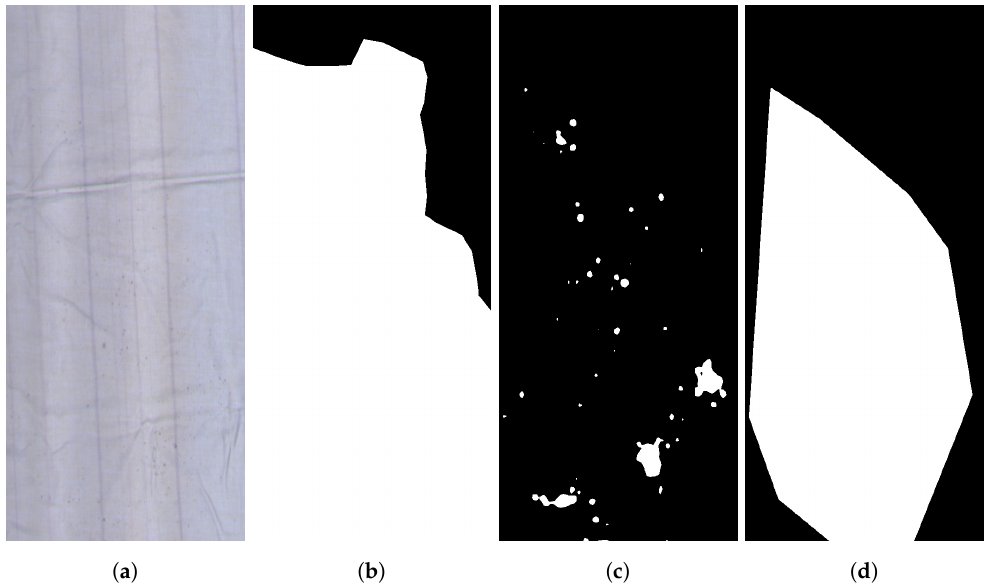
Figure 6. An illustration of the connection of predicted regions. ( a ) shows an image of our dataset and ( b ) shows a rough pixel-wise labeling. ( c ) is a prediction before the connection of regions and ( d ) is the prediction